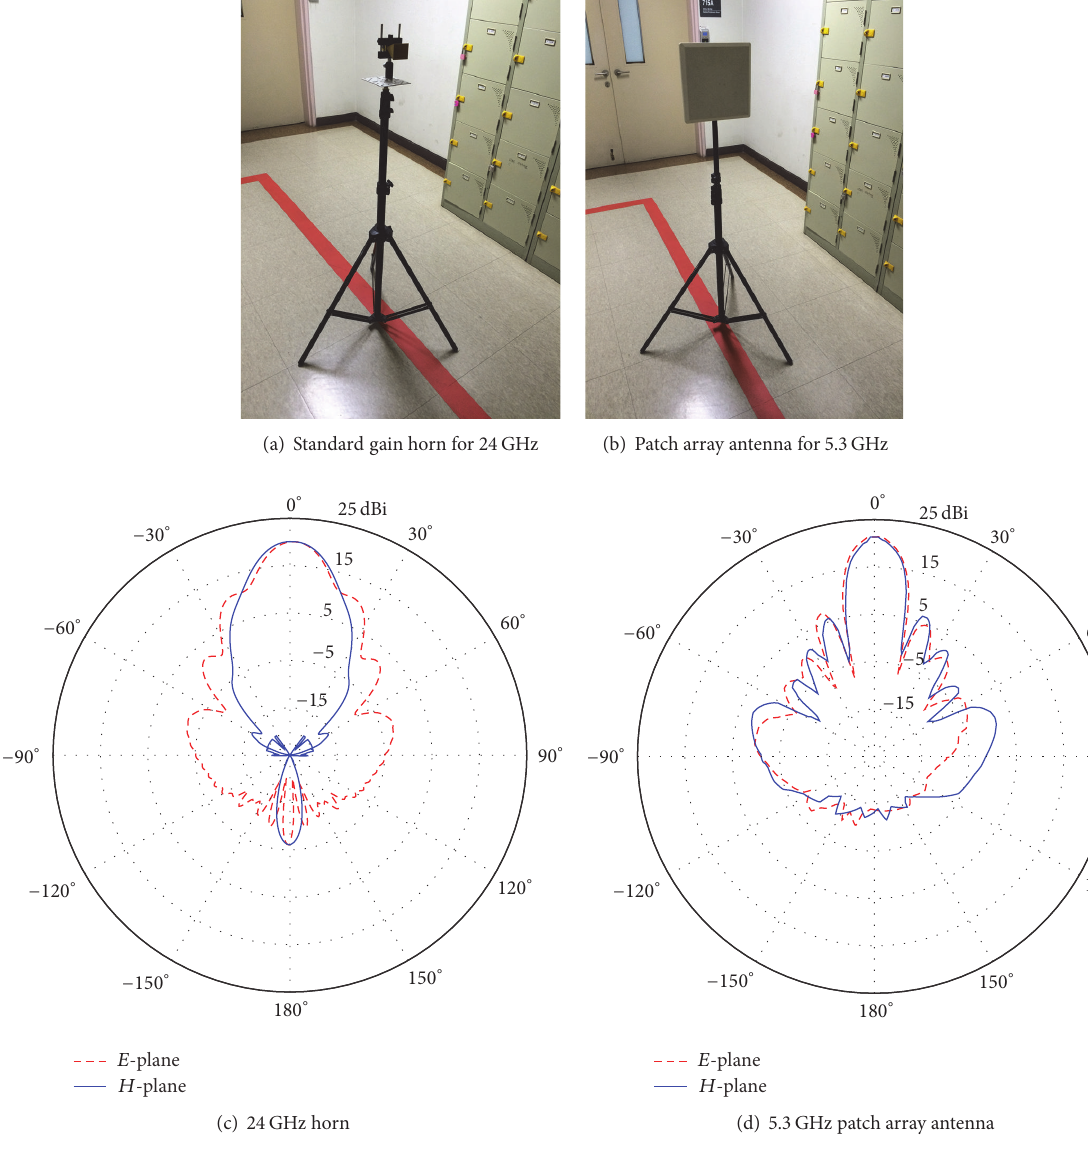
Figure 4: Antennas and radiation patterns of the channel